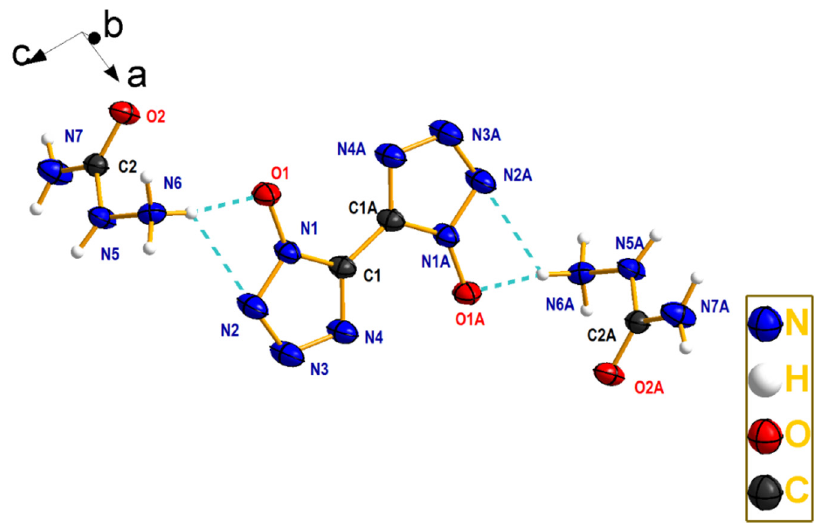
Figure 1. Molecular structure for salt 2(SCZ) ∙ BTO. The thermal ellipsoids are drawn at the 50% probability level, the symmetry operation code is –x + 1, − y + 1, − z + 2.